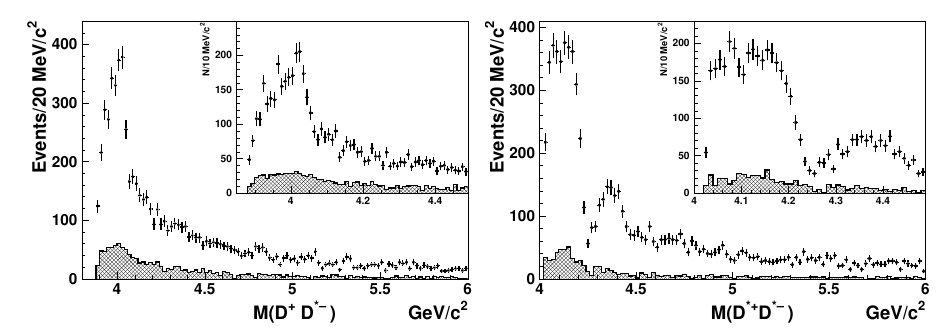
Figure 1. The a) D + D ∗− and b) D ∗ + D ∗− mass spectra in the data after applying all selection criteria (points with error bars). The sum of backgrounds (1)–(3) is shown as the hatched histogram. The inset shows the spectrum near the threshold with finer